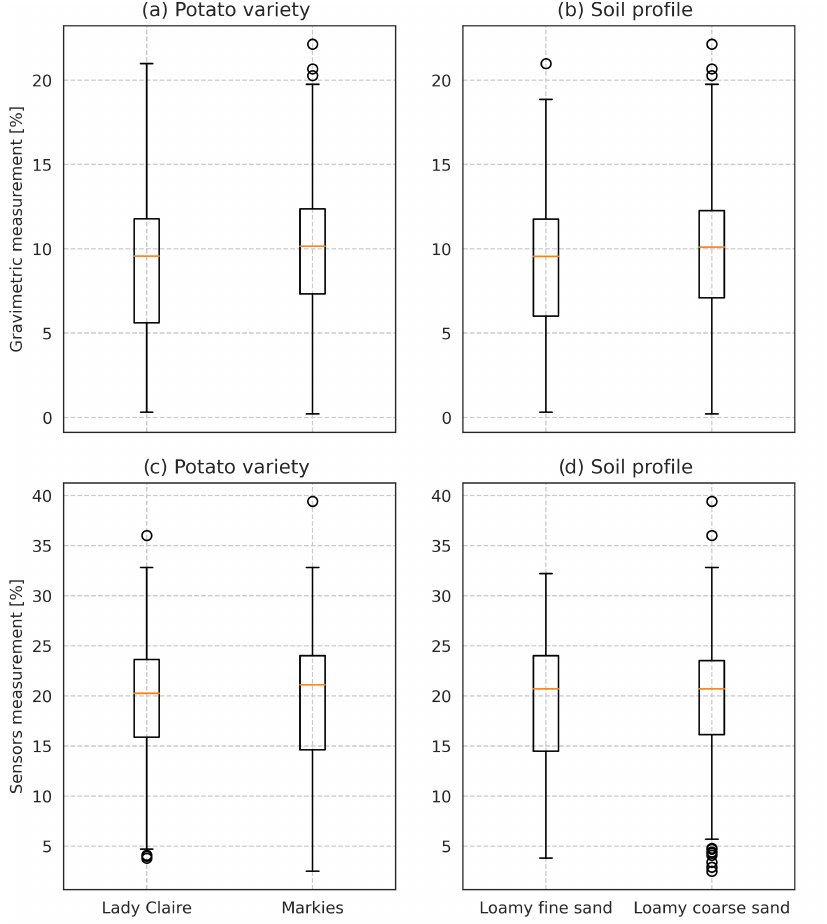
Figure 1. Moisture measurements’ subsets distribution, according to: variety for Lady Claire and Markies, according to: soil profile for loamy fine sand and loamy coarse sand separately, ( a , b ) presents gravimetric measurements; ( c , d ) presents sensor measurements. The box on the plots denotes quartiles (Q1, Q3), the middle horizontal line refers to the median, and the whiskers are calculated using the interquartile range, but drawn to the largest measurements within the calculated whisker. Measurements outside the whiskers are marked as outliers using